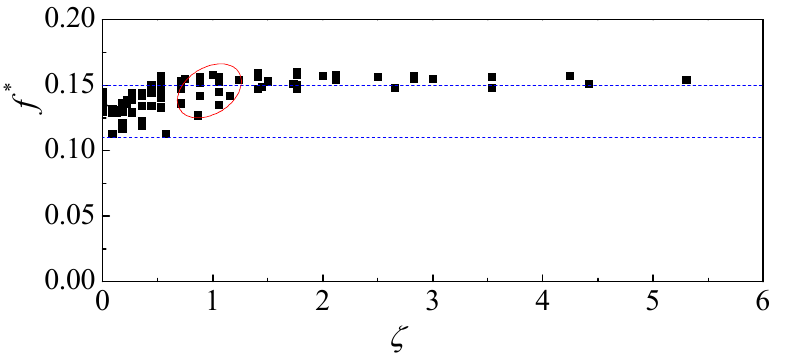
Figure 17. Reduced frequency characteristics of double-elastic-constrained flapping hydrofoil in all working conditions involved in this paper.